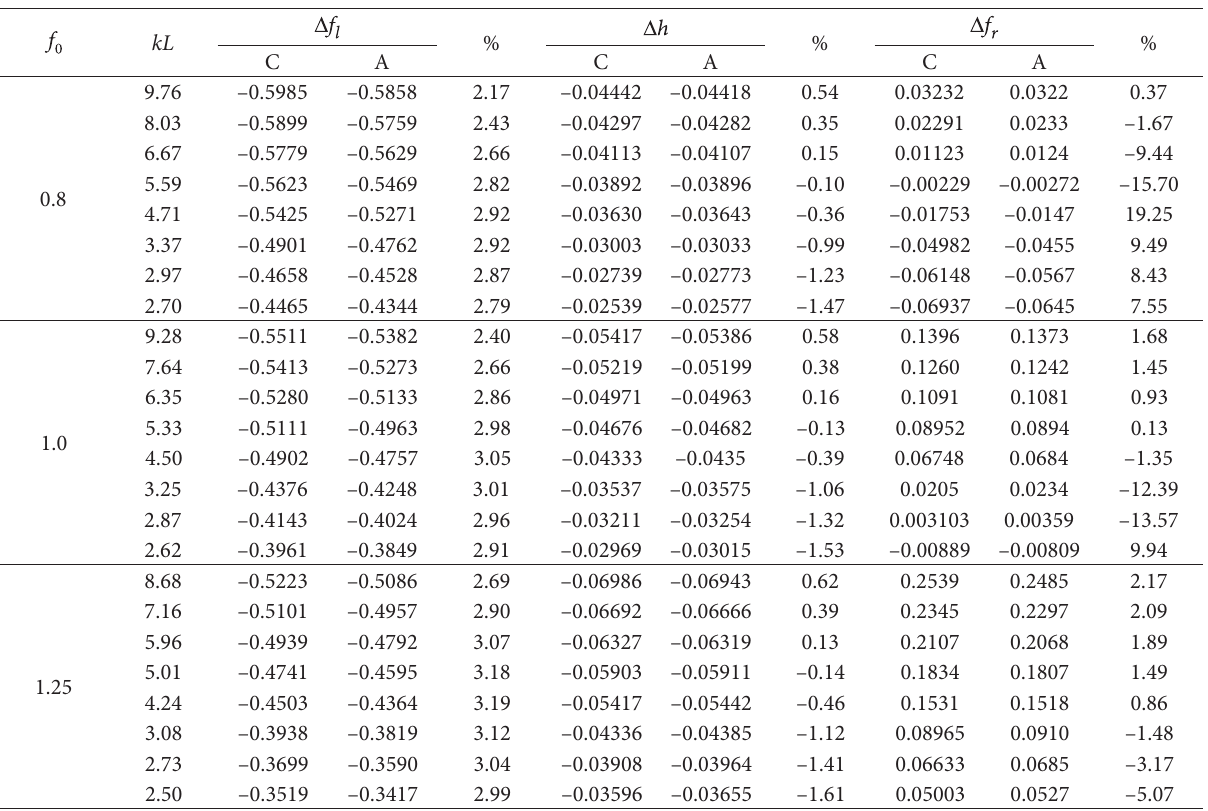
Table 2. Cosmos/M program (C) and the displacement values received after engineering calculation (A) kL